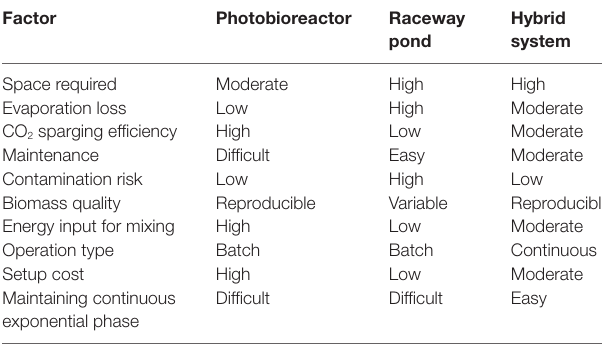
TaBle 1 | comparison of various microalgae cultivating methods considering findings from the present and previous studies. Factor Photobioreactor raceway